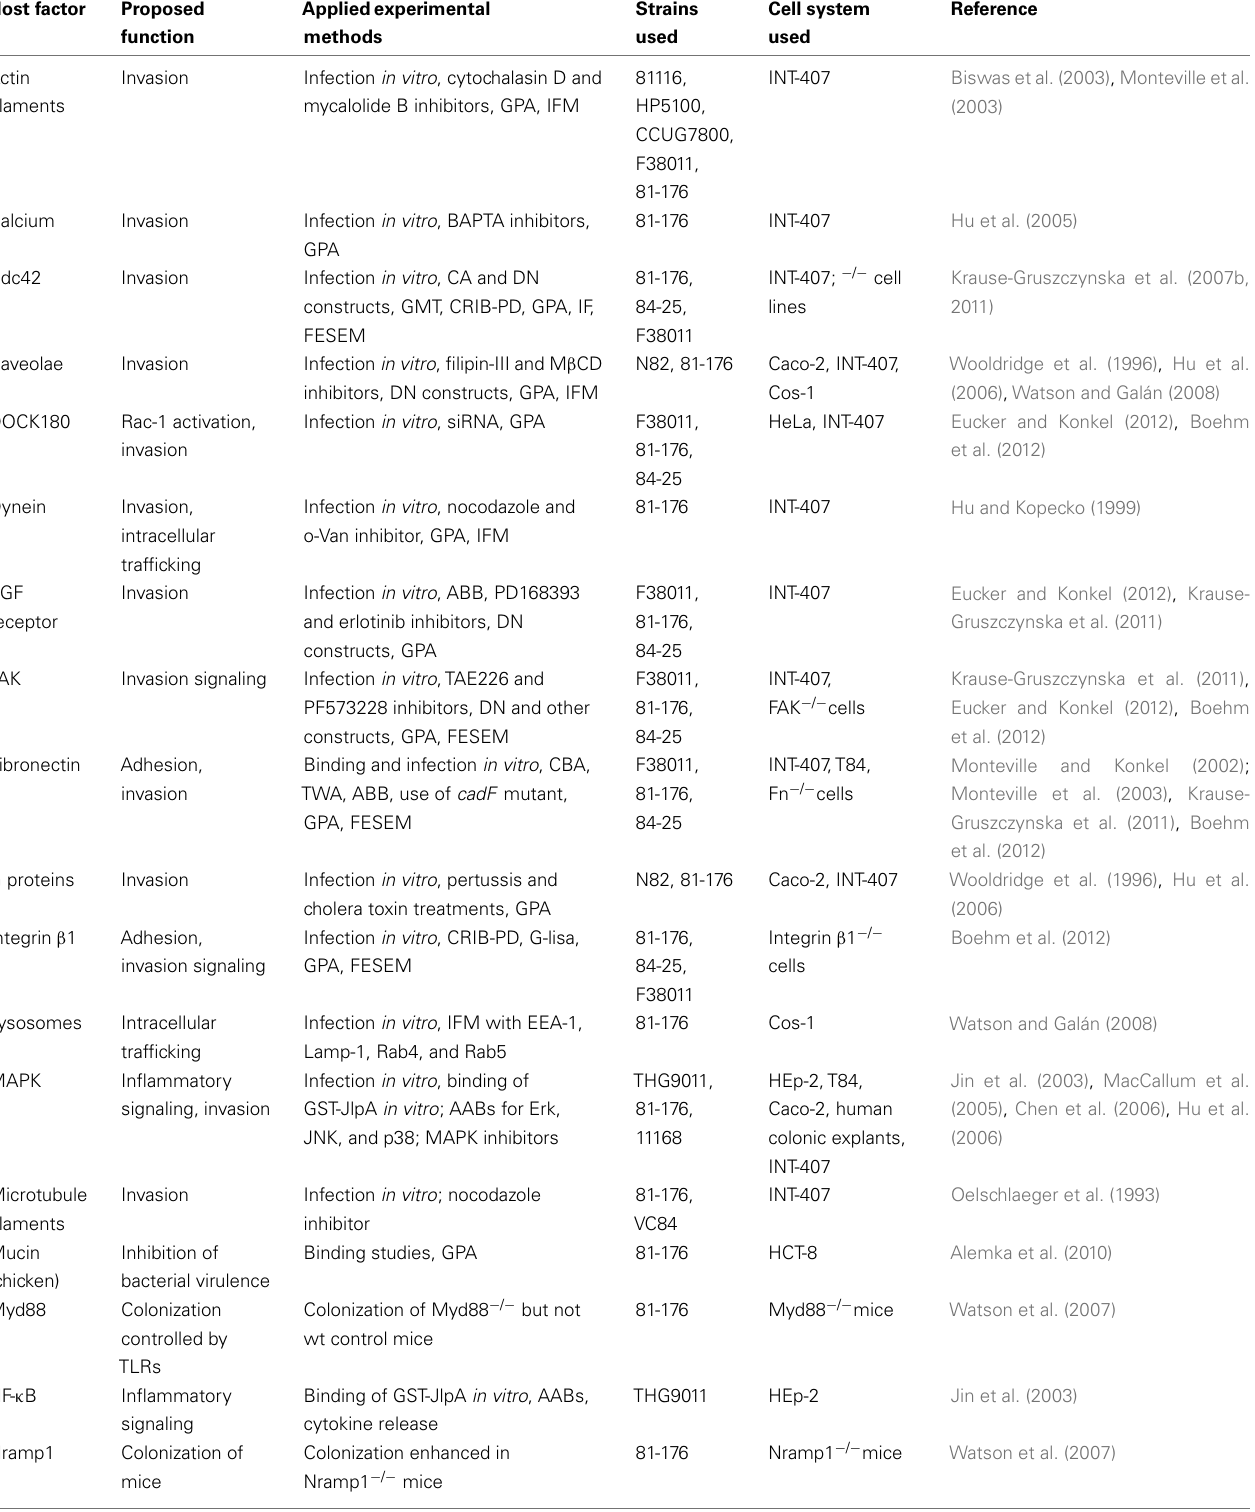
Table 2 | Host factors and proposed roles in C. jejuni